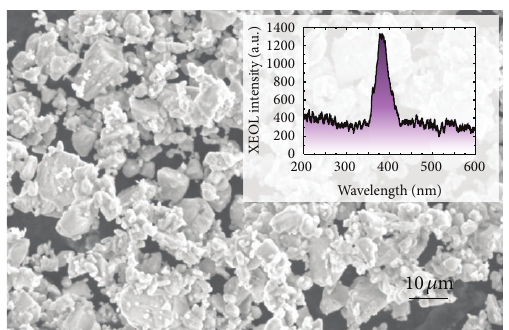
Figure 3: SEM image of the BaFCl:Eu 2+ powder and schematic diagramsofthecross-sectionandinternalstructure.Theinsetshows the XEOL spectrum of BaFCl:Eu 2+ powder under the irradiation of a 0.154nm X-ray (40kV, 20 mA).